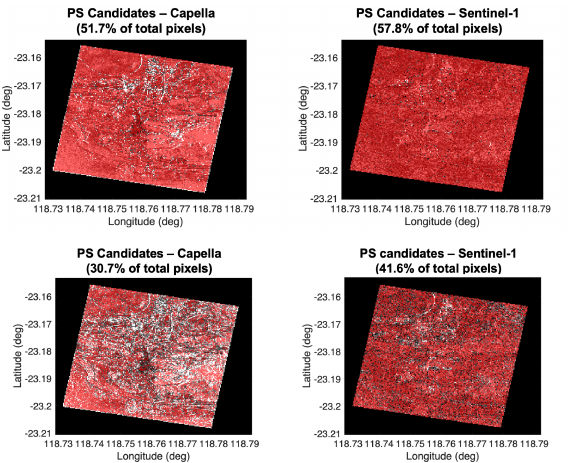
Figure 5. Comparison between Capella and Sentinel image stacks with an amplitude dispersion threshold of < 0.4 (top) and < 0.25 (bottom). The number in parentheses indicates the percentage of total pixels identified as PS